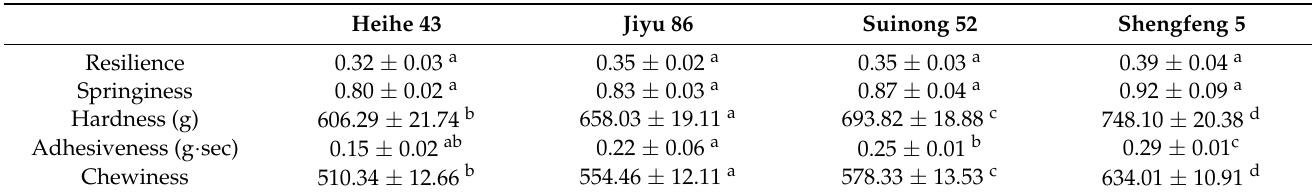
Table 4. Texture characteristics of four kinds of plant-based meat analogues (PBMs). Heihe